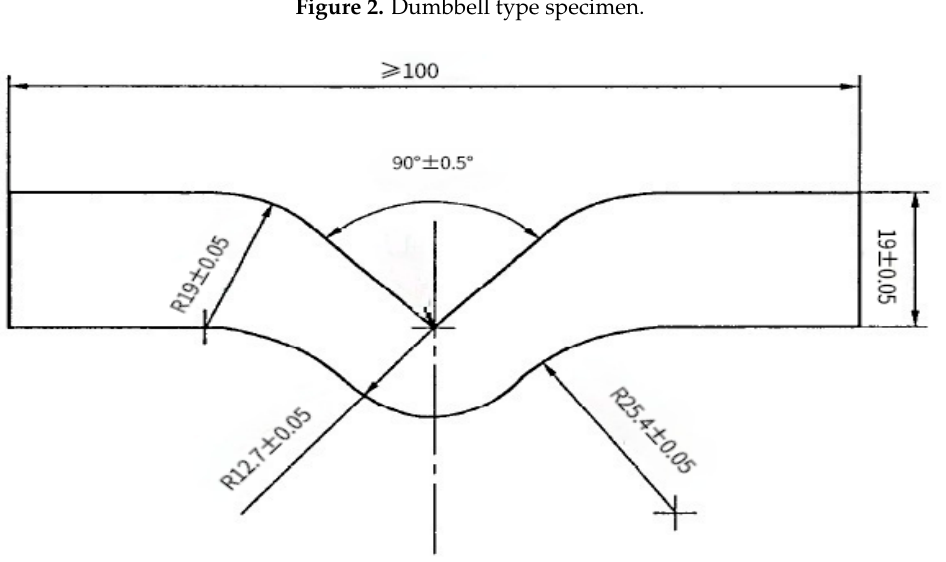
Figure 3. Right-angle specimen.